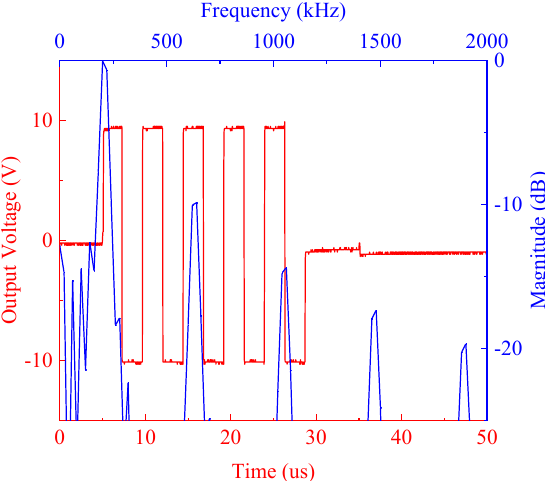
Figure 7. Photograph of the integrated front-end circuit board.